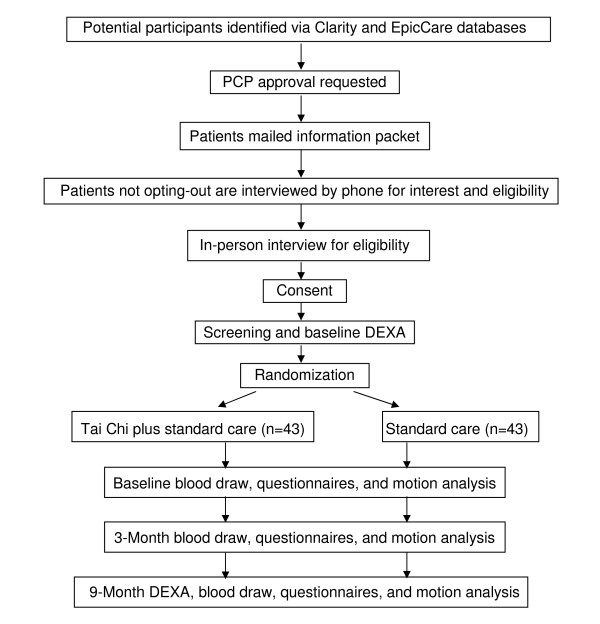
Study flow diagram.